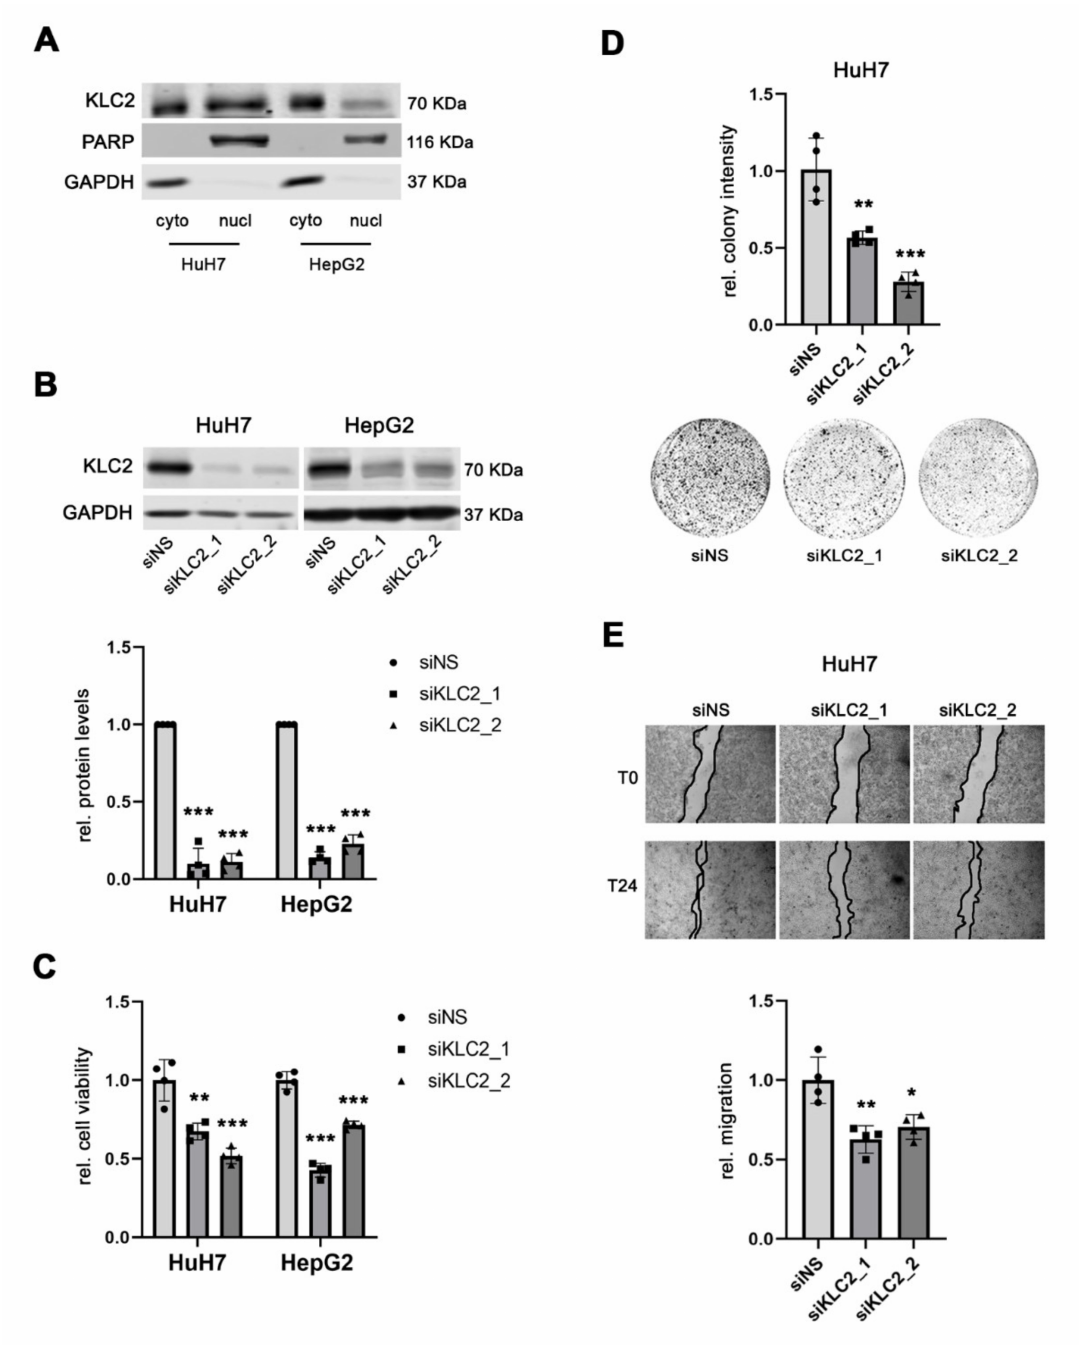
Figure 5. KLC2 exerts oncogenic functions in human HCC. ( A ) KLC2 is expressed both in the cytoplasmic and nuclear compartments of HuH7 and HepG2 cells. ( B ) Efficient siRNA-mediated knockdown of KLC2 protein levels in HuH7 and HepG2 cells compared to siNS control transfected cells. ( C , D ) Reduced cell viability and clonogenicity of both HuH7 and HepG2 cells following specific siRNA-mediated knockdown of KLC2 compared to siNS transfected control. ( E ) Migratory capacity of HuH7 cells either treated with KLC2-specific or siNS control siRNAs. Data are presented as mean ± SD of 4 independent experiments; in 5B only the upper error bar is displayed for graphical appearance reason. Welch’s t -test in ( B ), and unpaired t -test in ( C – E ): * p < 0.05, ** p < 0.01, *** p < 0.001. Abbreviations: cyto, cytoplasmatic protein fraction; nucl, nuclear protein fraction; siNS, scrambled, nonsense siRNA; siKLC2_1/_2, siRNA 1 and 2 specifically targeting KLC2; rel.,